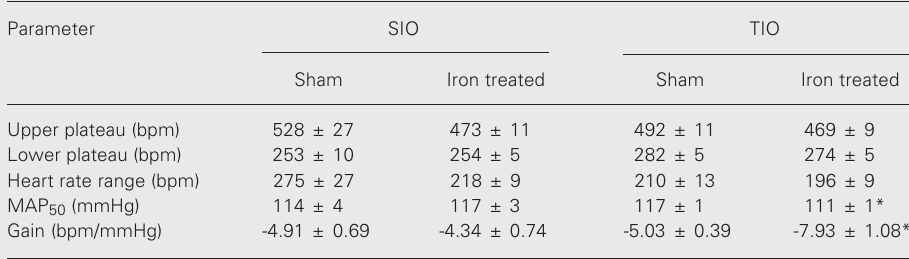
Table 2. Baroreflex curve parameters of sham, serum iron overload and tissue iron overload